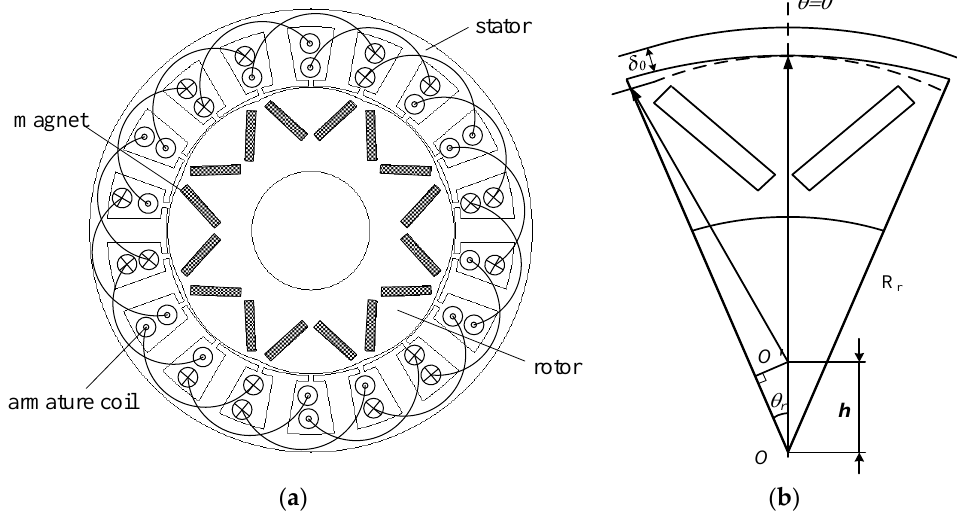
Figure 1. ( a ) Topological structure of AGE-IPMSM. ( b ) Schematic diagram of air-gap eccentric structure.